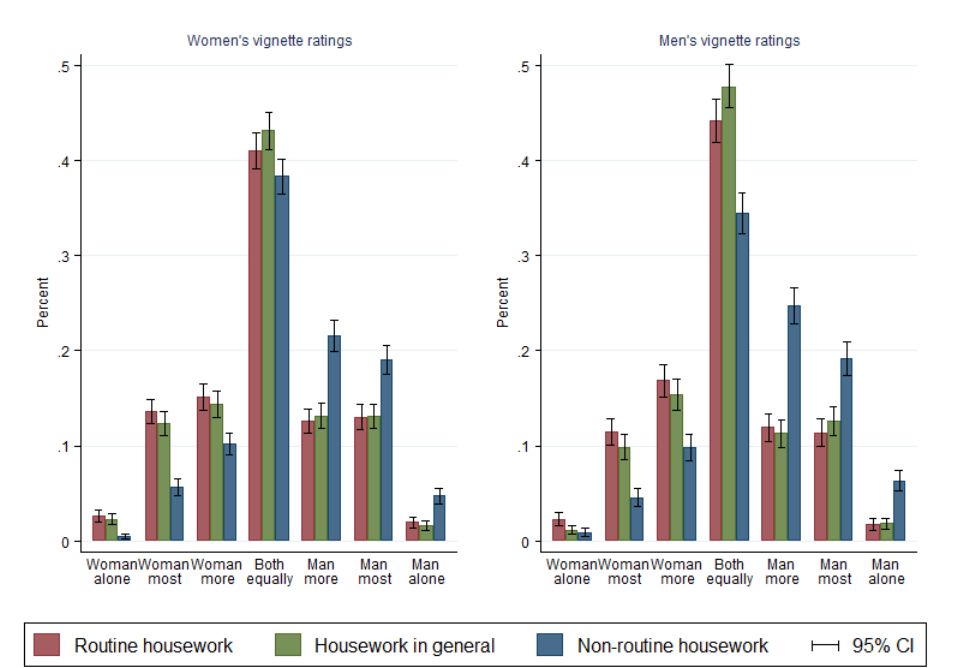
Figure 2 : Women’s and men’s attitudes towards housework in general, routine housework, and non-routine